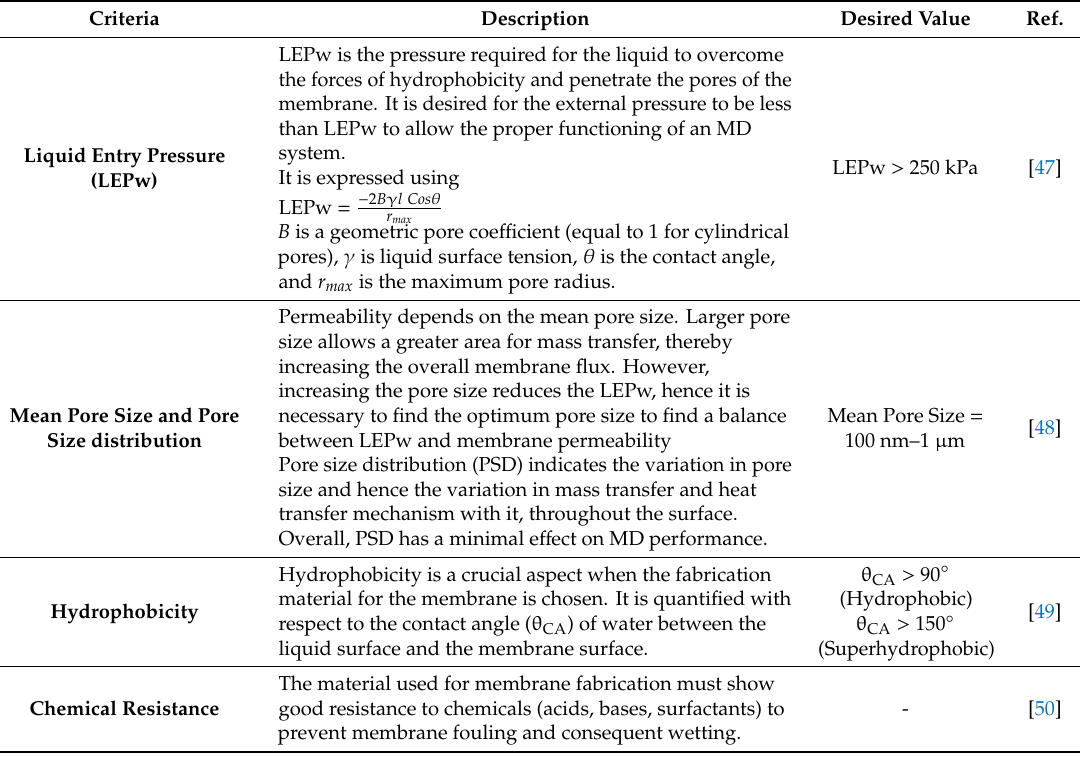
Table 1. Overview of desired membrane characteristics for MD